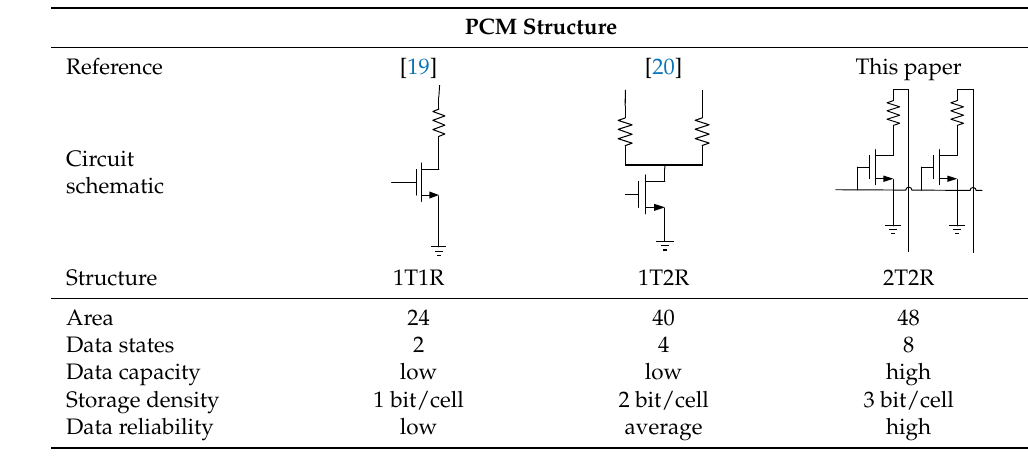
Table 3. The comparison between the proposed structure and the previous.